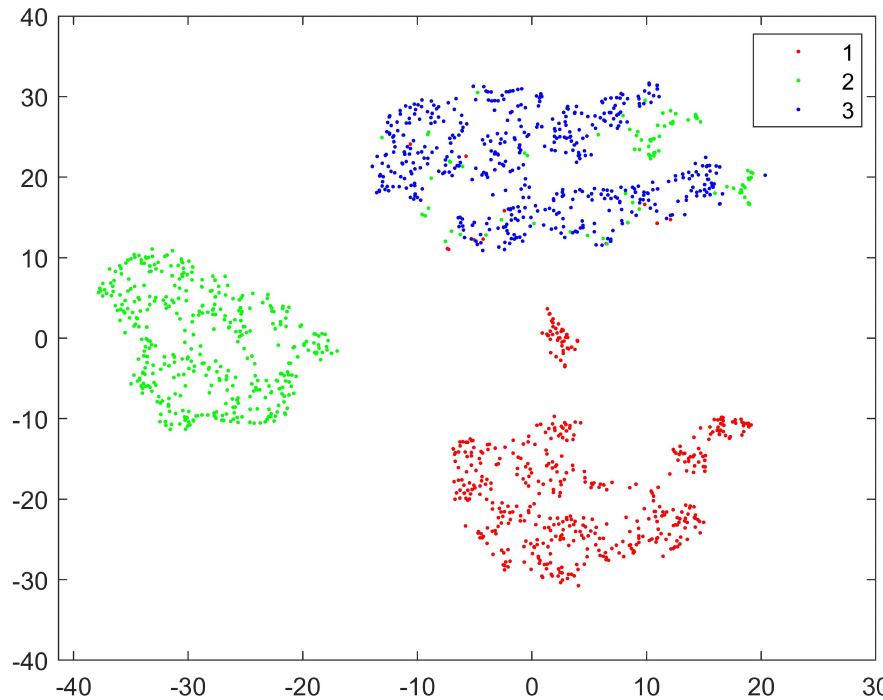
Figure 7. TSNE visual output of fault 1, 2, 3.